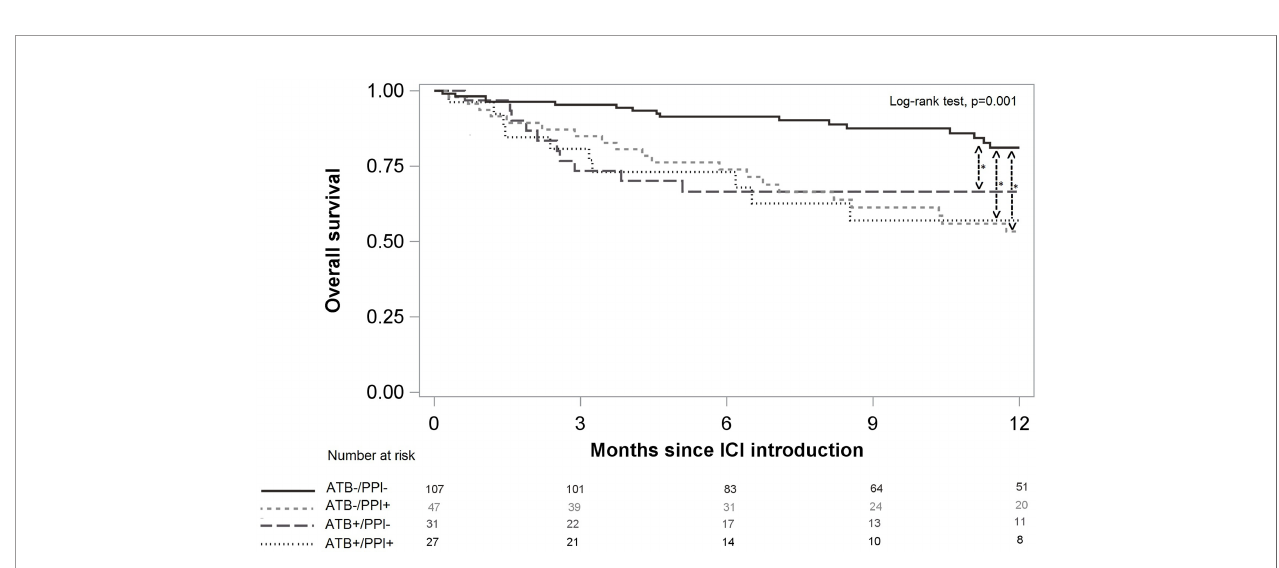
FIGURE 3 | Progression free survival according to ATB and/or PPI use. Signi fi cant differences after multivariate analysis are symbolized with a star.